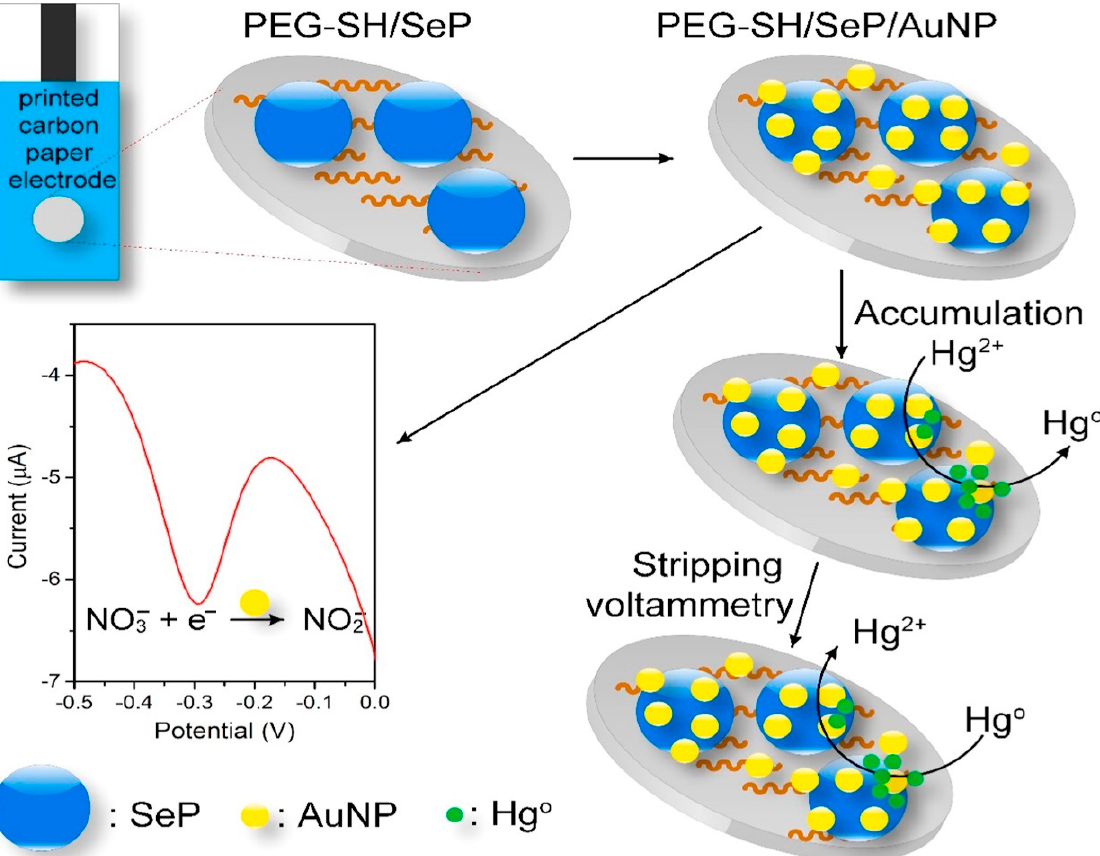
Figure 8. The graphic design of the fabrication procedure and reactions occurring on the SePs/AuNPs modified disposable carbon paper electrode for the detection of NO 3 − and Hg 2+ . Reprinted with permission from [185]. Copyright © 2021 Elsevier B.V. All rights reserved.